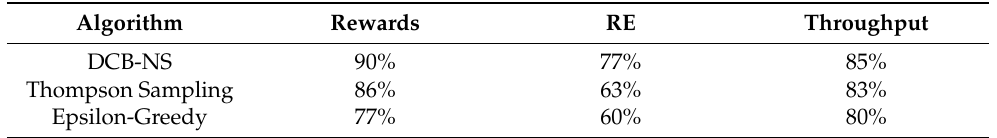
Table 4. The proposed scheme’s average performance comparison with the Epsilon–Greedy and Thompson Sampling